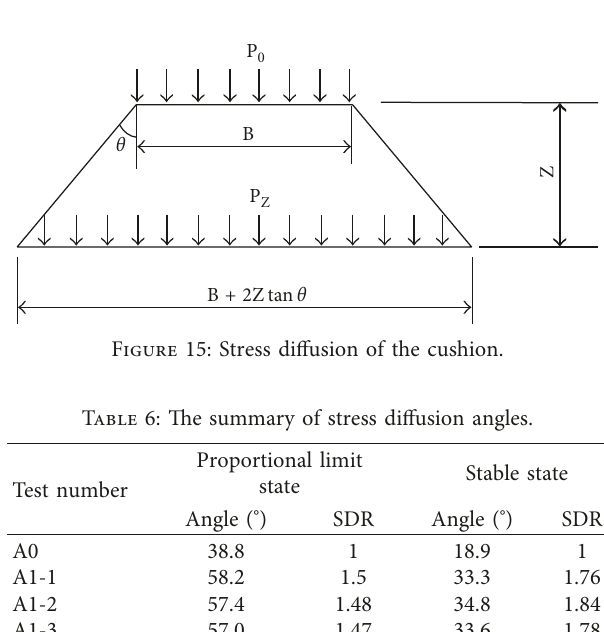
Figure 14: Calculation sketch of average earth pressure under the